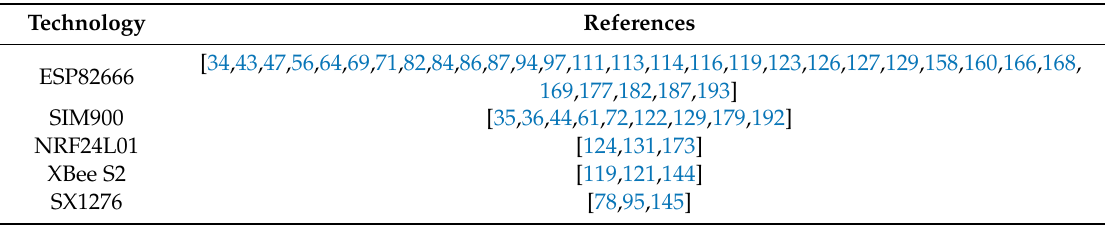
Table 7. Most utilized communication modules.